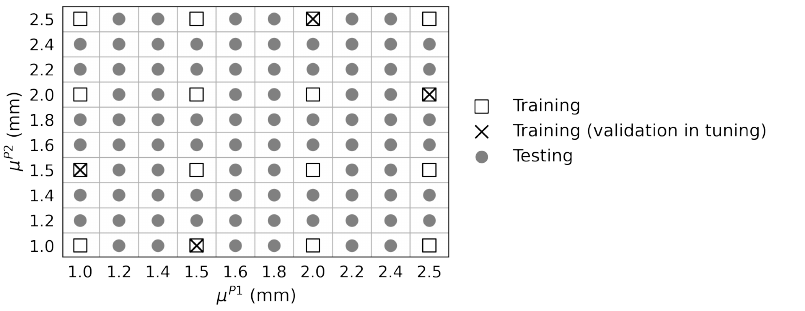
Figure 5. Distribution in parametric space of training and testing sets for model H 1 .